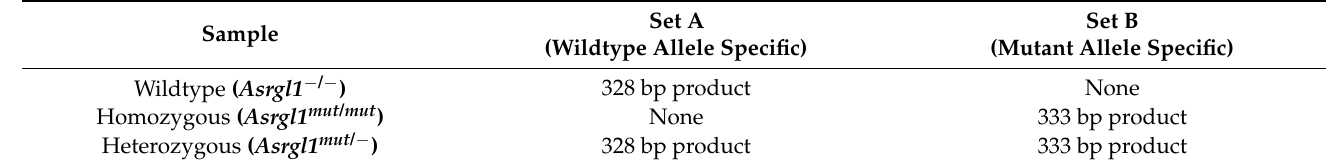
Table 2. Primer details for the Asrgl1 mut/mut mice genotyping.